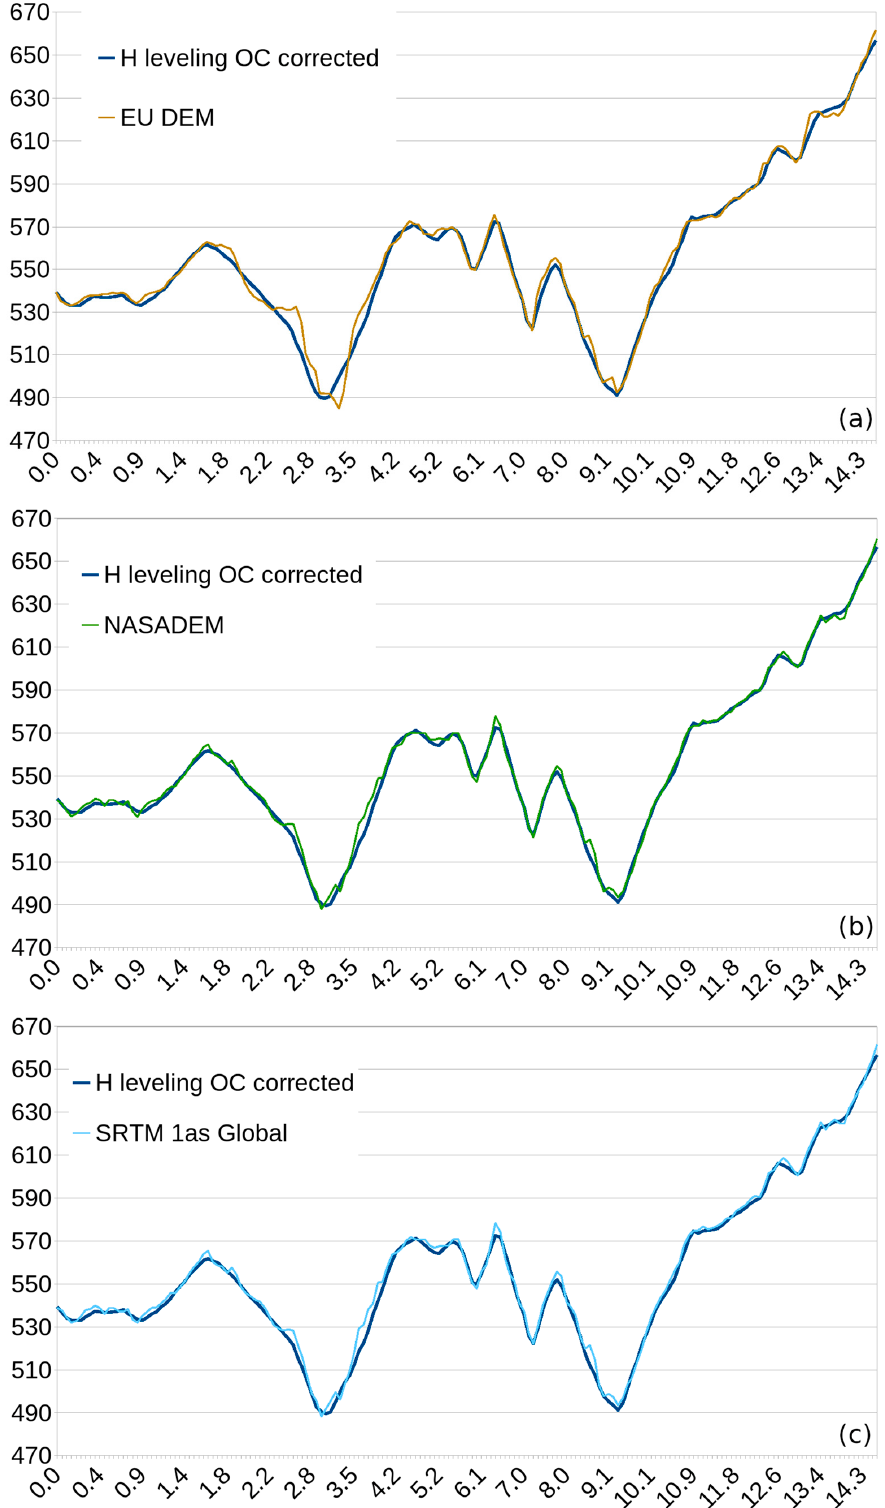
Figure 7. Height values along the traverse in Northern Greece from ( a ) EU ‐ DEM (dark orange line) and leveling, ( b ) NASADEM (green line) and leveling, and ( c ) SRTM Global (light blue line) and leveling. ( x ‐ axis: distance in km/ y ‐ axis: height in m).